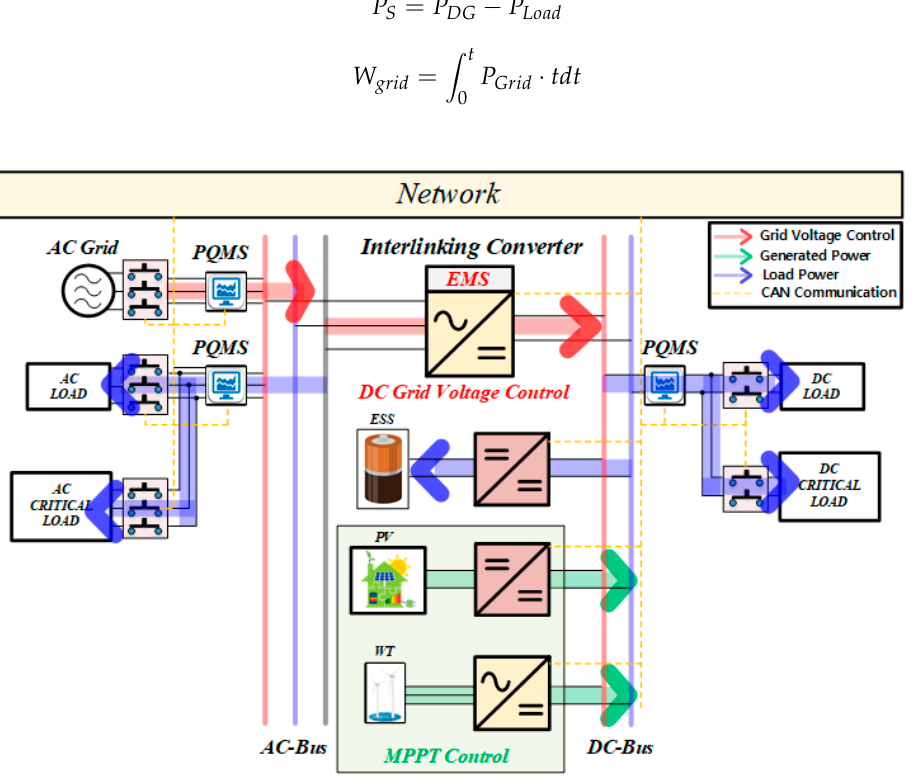
Figure 7. Power flow diagram of ESS charge mode (mode 1).